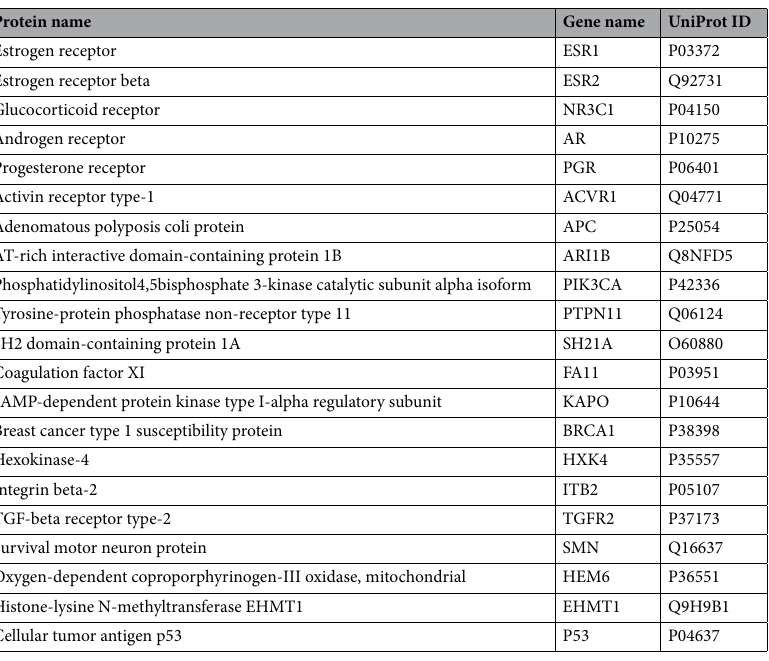
Table 4. The detailed information of 22 target